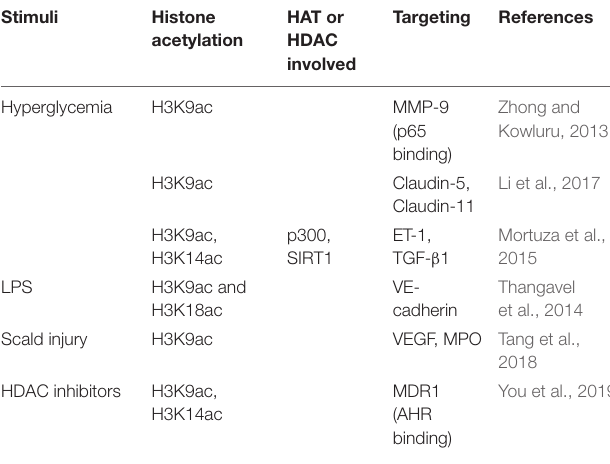
TABLE 5 | EC barrier function mediated by histone